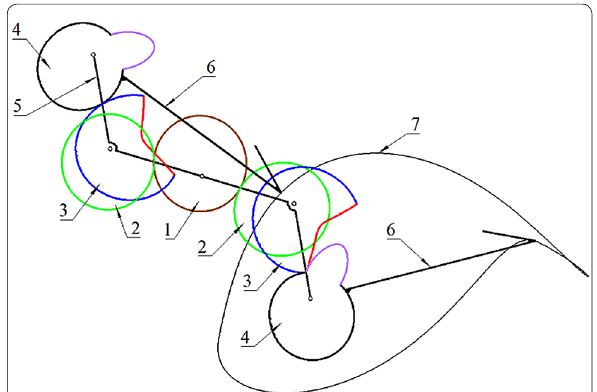
Figure 16 Two-jaw pattern of the seedling pick-up mechanism: 1. Sun gear, 2. First middle gear, 3. Second middle gear, 4. Planet gear, 5. Planet frame, 6. Seedling arm, and 7. Seedling pick-up trajectory